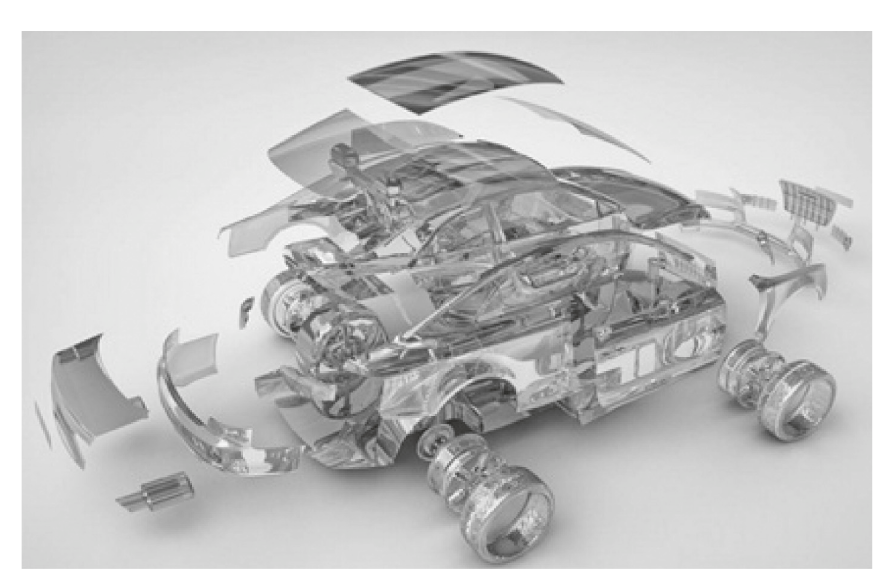
Figure 4: Split diagram of auto